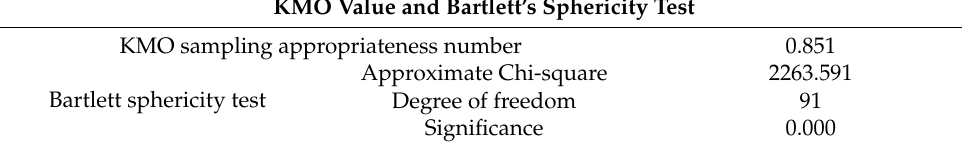
Table 3. KMO value and Bartlett’s sphericity test.